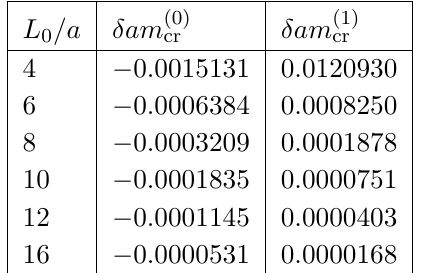
Table 3 . Tree-level and one-loop cutoff effects for the critical mass in the SF for setup A with background gauge field, θ = π/ 5 and improvement coefficients as specified in ref. [50]. Note that the one-loop coefficient depends on the number of flavours, δam (1) cr = δam (1 , 0) cr + δam (1 , 1) cr N f , with numerical values taken from